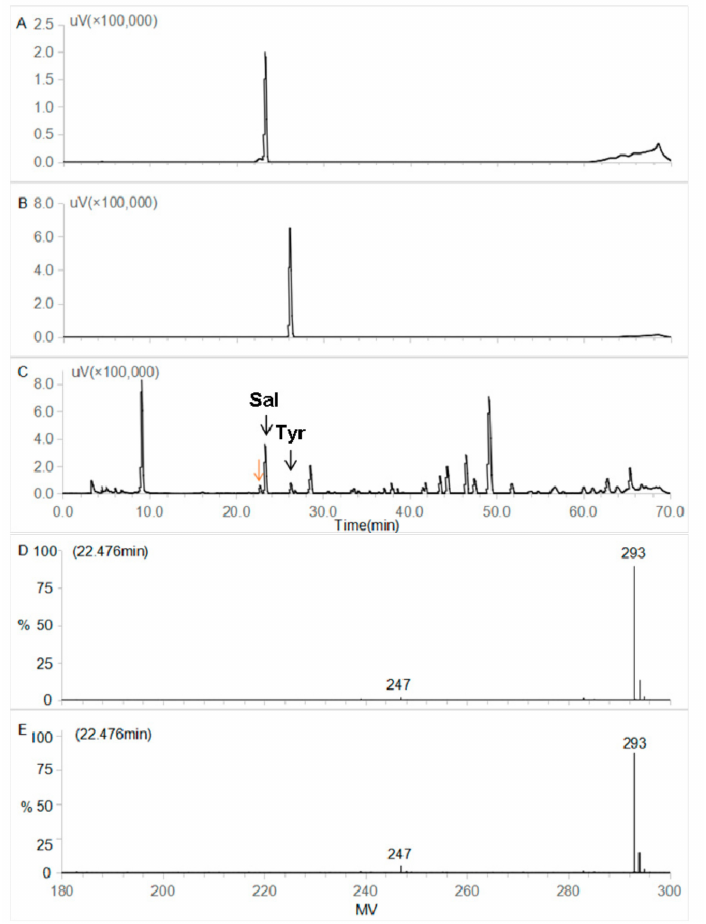
Figure 4. Liquid chromatographic profiles of salidroside, p -tyrosol and RCE, and ion fragment profiles of Q-TOF-MS presented at 22.476 min (yellow arrow). Shown in sequence are Liquid chromatographic profiles of salidroside ( A ), p -tyrosol ( B ) and R. crenulata crude extract (RCE) ( C ); ion fragment at 22.476 min by Q-TOF-MS-ES − (D) and ion fragment at 22.476 min by Q-TOF-MS/MS-ES - ( E ). Sal and Tyr refer to salidroside and p -tyrosol,